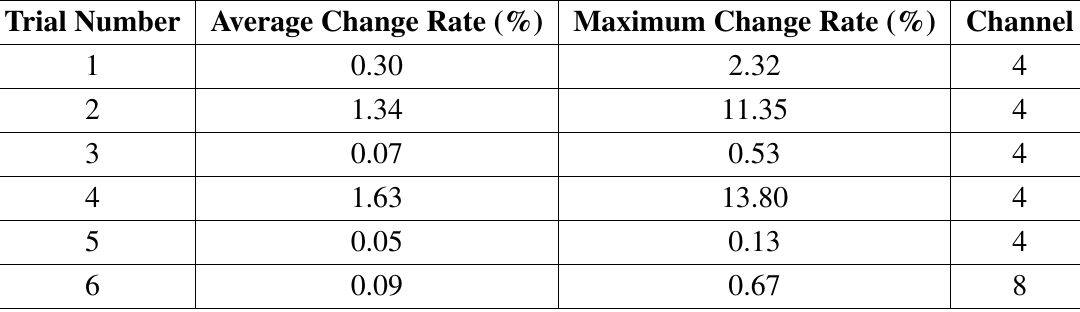
Table 1. Change rate of the